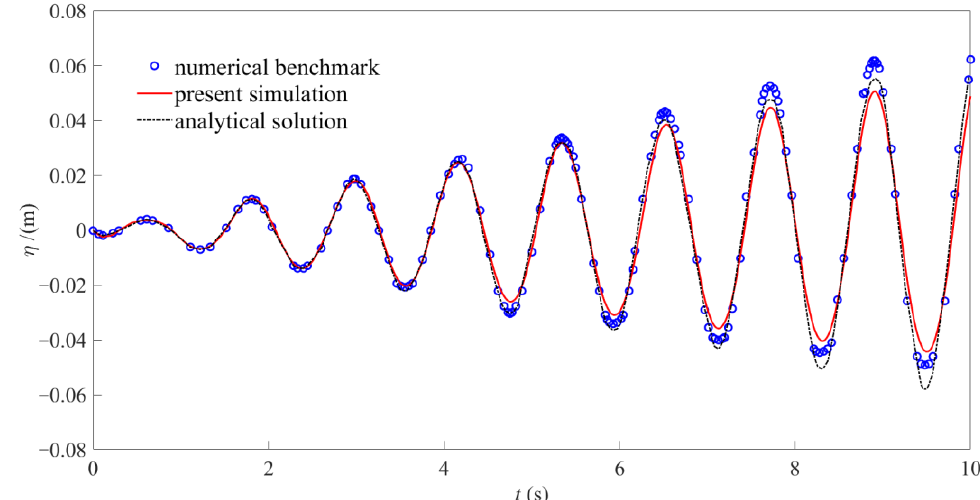
Figure 3. Comparison of the time history of free surface elevation at y = 0 between the results of the present simulation, numerical benchmark of Liu and Lin [35] and analytical solution of Faltinsen [34].